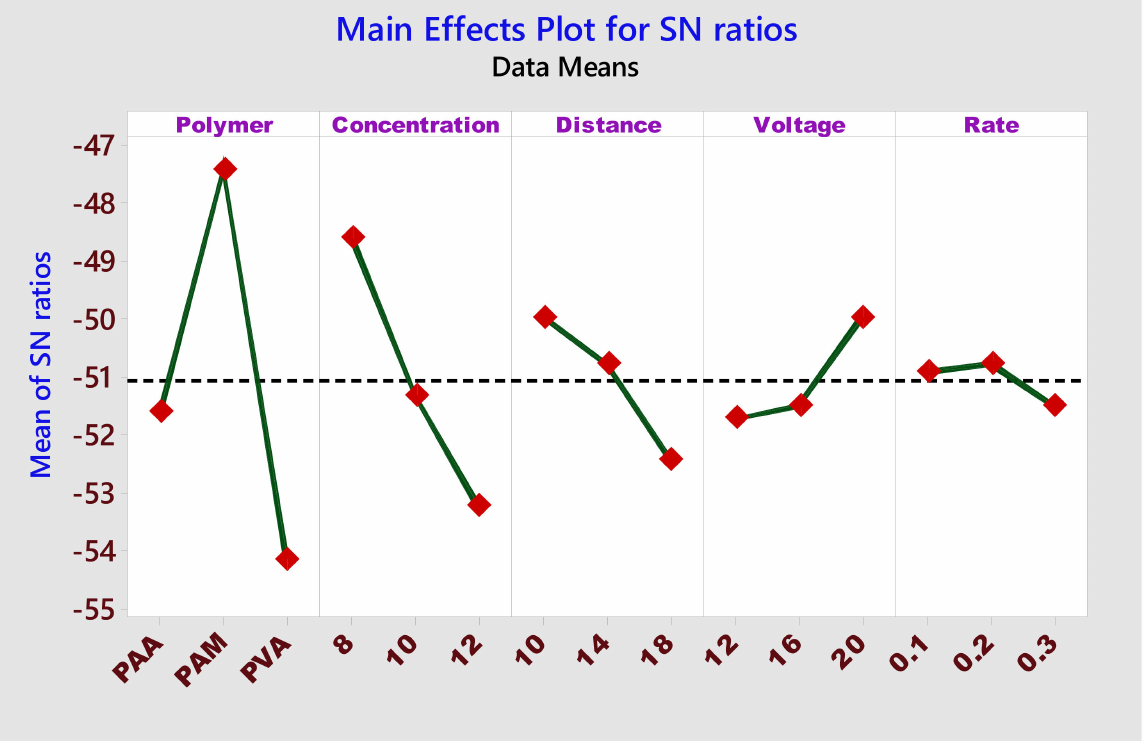
Figure 7. Average S/N ratio diagram for the determination of the optimum combination of factors for electrospun polymer nanofibers with the smallest nanofiber diameter size and its minimum